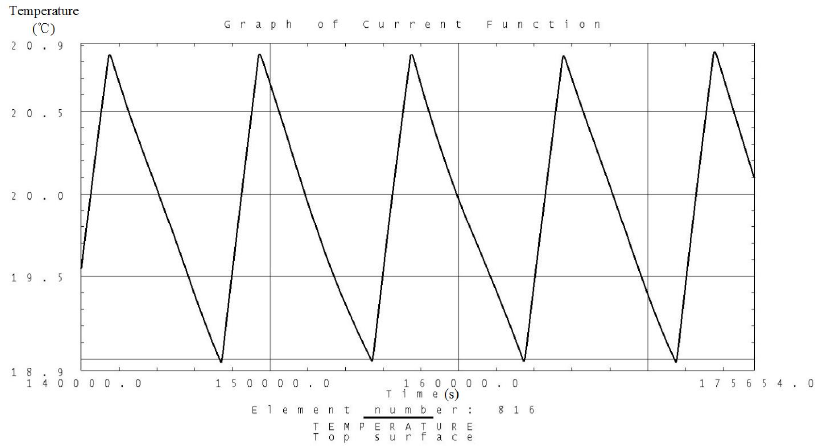
Figure 10. Analysis result of the temperature variation curve of the battery under low temperature conditions.